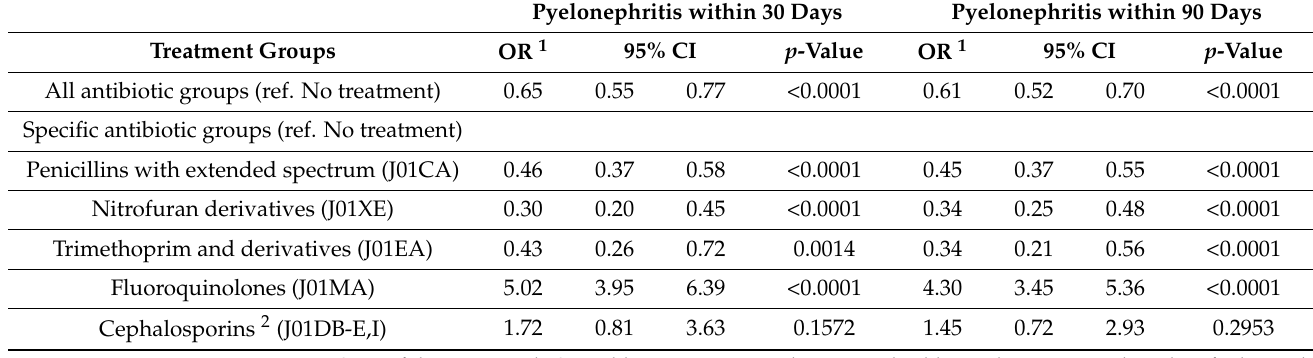
Table 5. The association between antibiotic treatment (redeemed within five days) for acute uncom- plicated cystitis and hospitalization due to acute pyelonephritis within 30 days and 90 days from the cystitis event